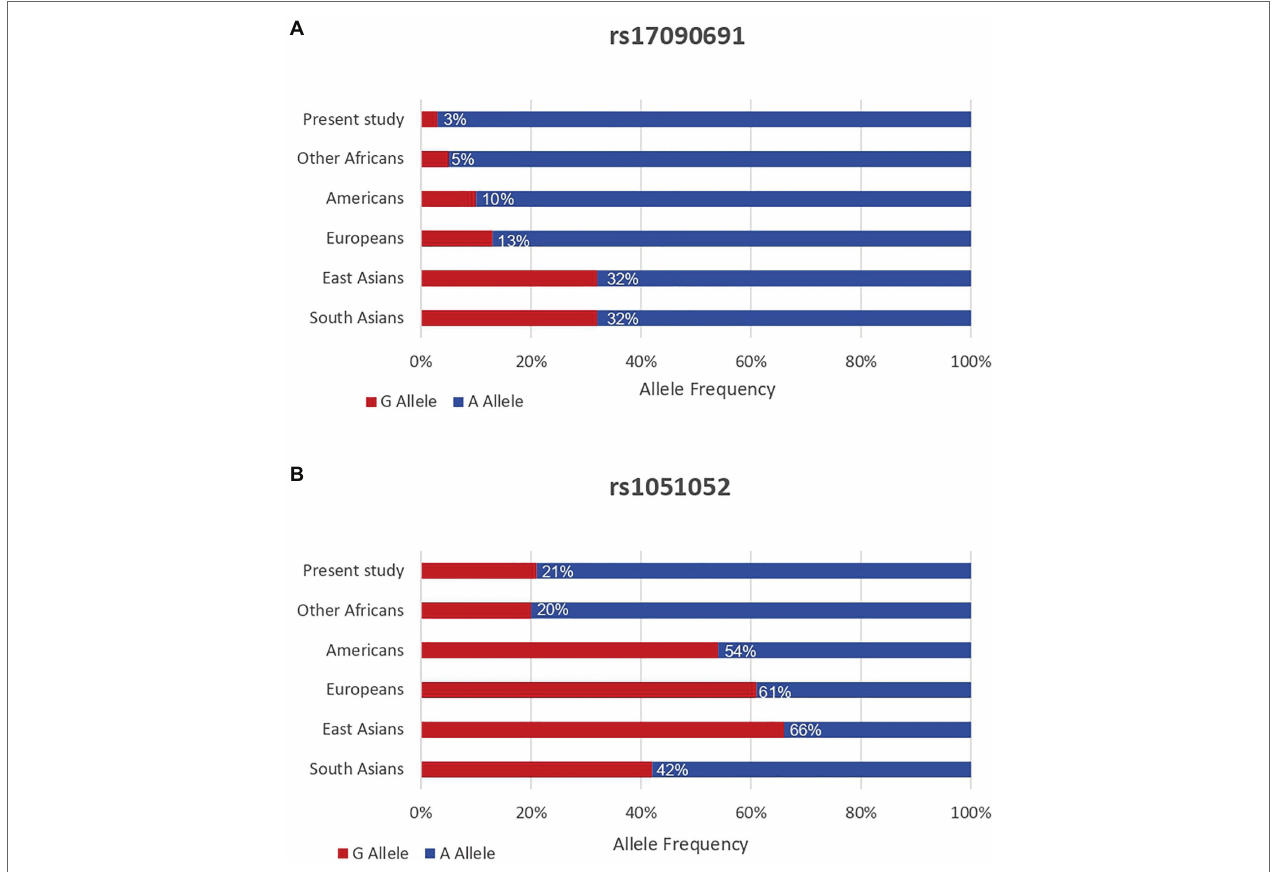
FIGURE 4 | Allele frequencies for SERPINA6/A1 rs17090691-G (A) and rs1051052-G (B) variants in the present study sample ( n = 4,431) and other global populations. Minor allele frequencies from the other populations were obtained from the 1,000 Genomes Project phase 3 dataset. Other Africans include Yoruba in Ibadan (Nigeria), Luhya in Webuye (Kenya), Gambian in Western Divisions (Gambia), Mende (Sierra Leone), Esan (Nigeria), Americans of African Ancestry in SW (United States), and African Caribbeans (Barbados). Europeans include Utah Residents (CEPH) with Northern and Western European Ancestry, Toscani (Italy), Finnish (Finland), British (England and Scotland), and Iberian Population (Spain). Americans include Mexican Ancestry from Los Angeles (United States), Puerto Ricans (Puerto Rico), Colombians from Medellin (Colombia), and Peruvians from Lima (Peru). East Asians include Han Chinese in Beijing (China), Japanese in Tokyo (Japan), Southern Han Chinese, Chinese Dai in Xishuangbanna (China), and Kinh in Ho Chi Minh City (Vietnam). South Asians include Gujarati Indian from Houston (Texas), Punjabi from Lahore (Pakistan), Bengali (Bangladesh), Sri Lankan Tamil (the United Kingdom), and Indian Telugu (the United